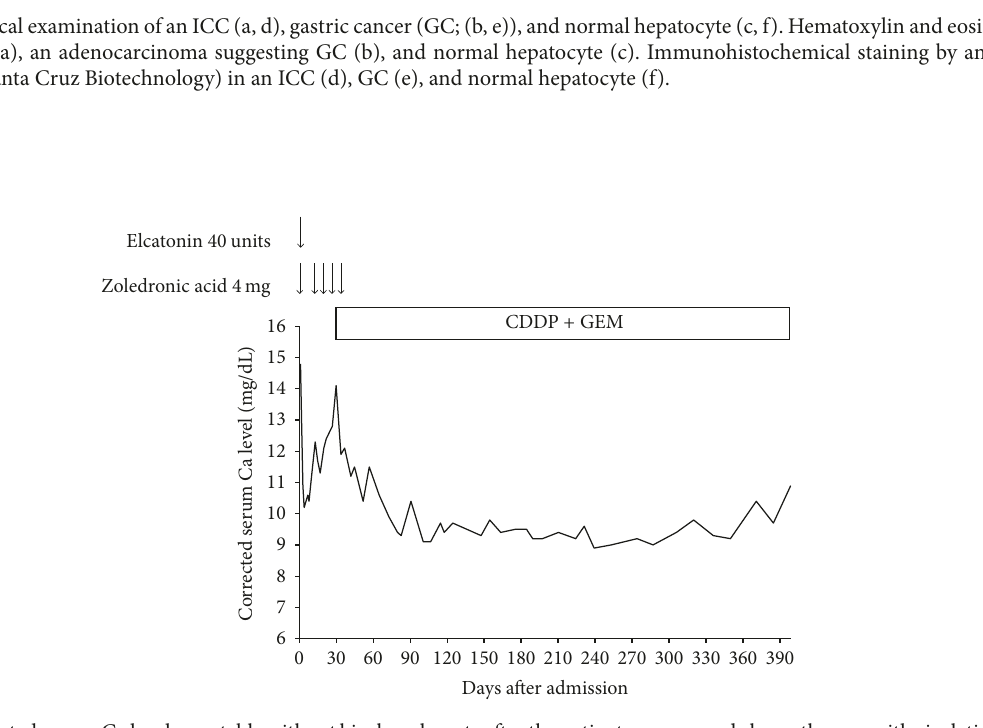
Figure4:ThecorrectedserumCalevelwasstablewithoutbisphosphonateafterthepatientcommencedchemotherapywithcisplatin(CDDP) and gemcitabine